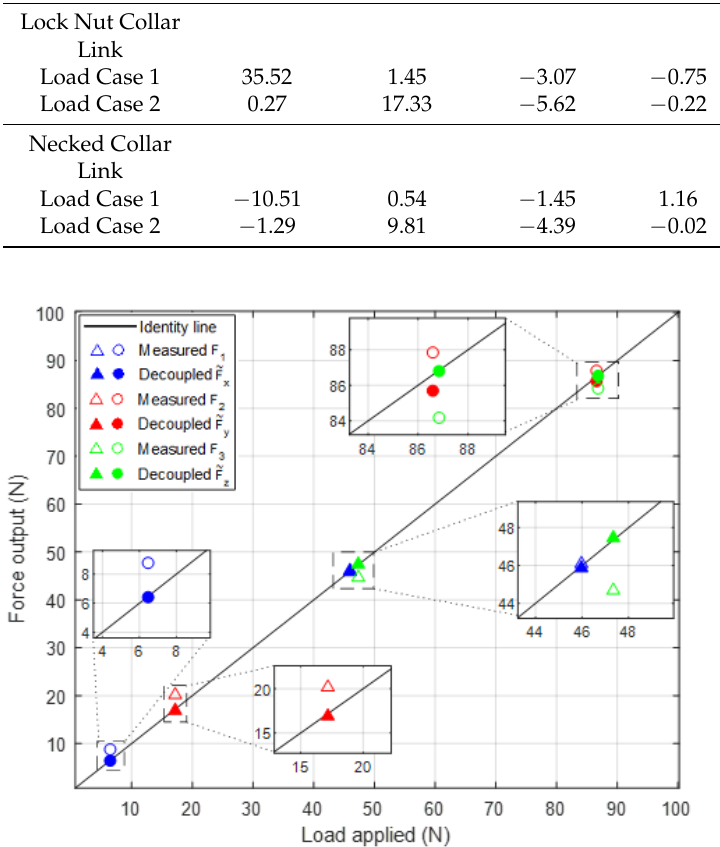
Figure 7. Decoupling method applied to locknut collar links (Load case 1: Circles; Load case 2: Triangles).